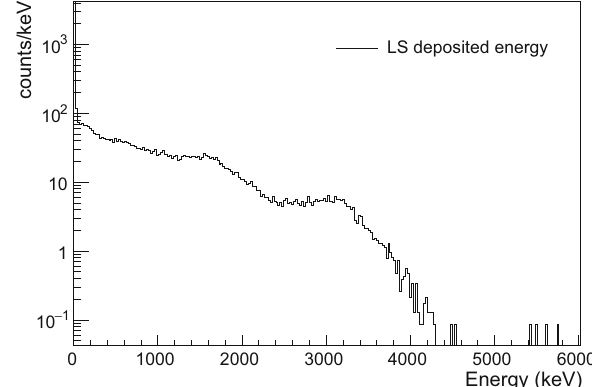
Fig. 5 TheLSenergyspectrumforinitial16.7daysofdata.Thesignals from all 18 readout PMTs are summed. Note that the LS PMTs are not included in the event trigger. Only passive data that occur during a time window that includes the crystal trigger time are